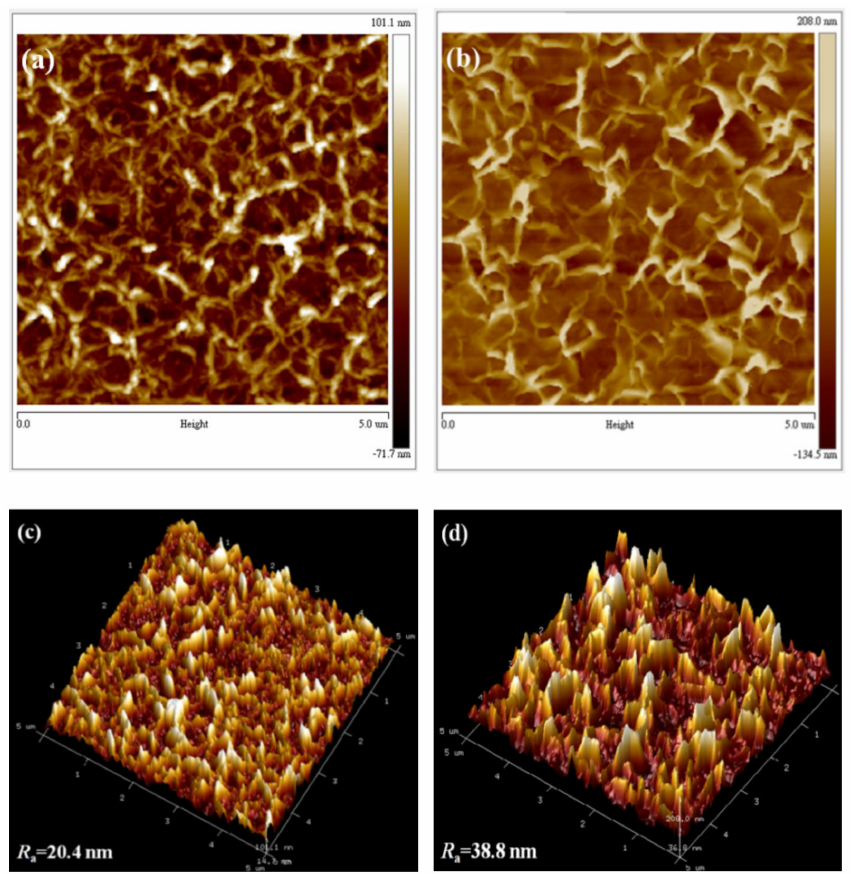
Figure 5. AFM topographic and 3D images of the Ni-doped ZnO NWLs with HMT concentrations of ( a , c ) 3 and ( b , d ) 5